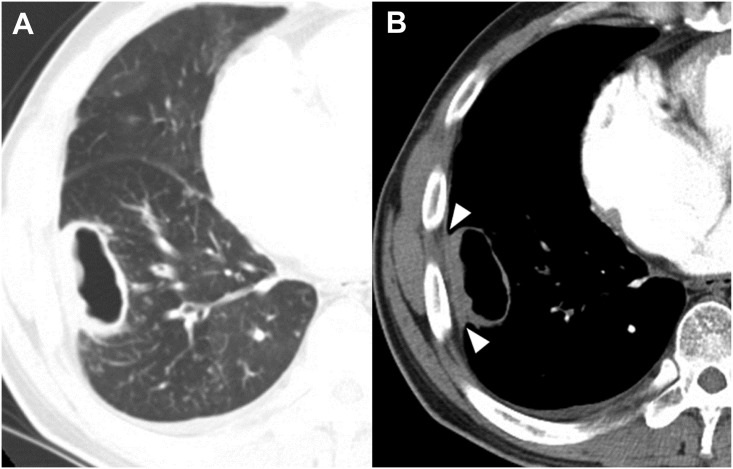
CT images of a Mycobacterium avium pulmonary infection in a 44-year-old man.Axial CT images with lung and mediastinal window settings (2.5-mm slice) were obtained at the level of the segmental bronchi of the right lower lobe. The CT images show relatively thin and relatively even thickening of the cavity, and tiny ill-defined satellite nodules (<4 mm) with air trapping in the right lower lobe. Note pleural thickening next to the cavity (B) (arrowheads).